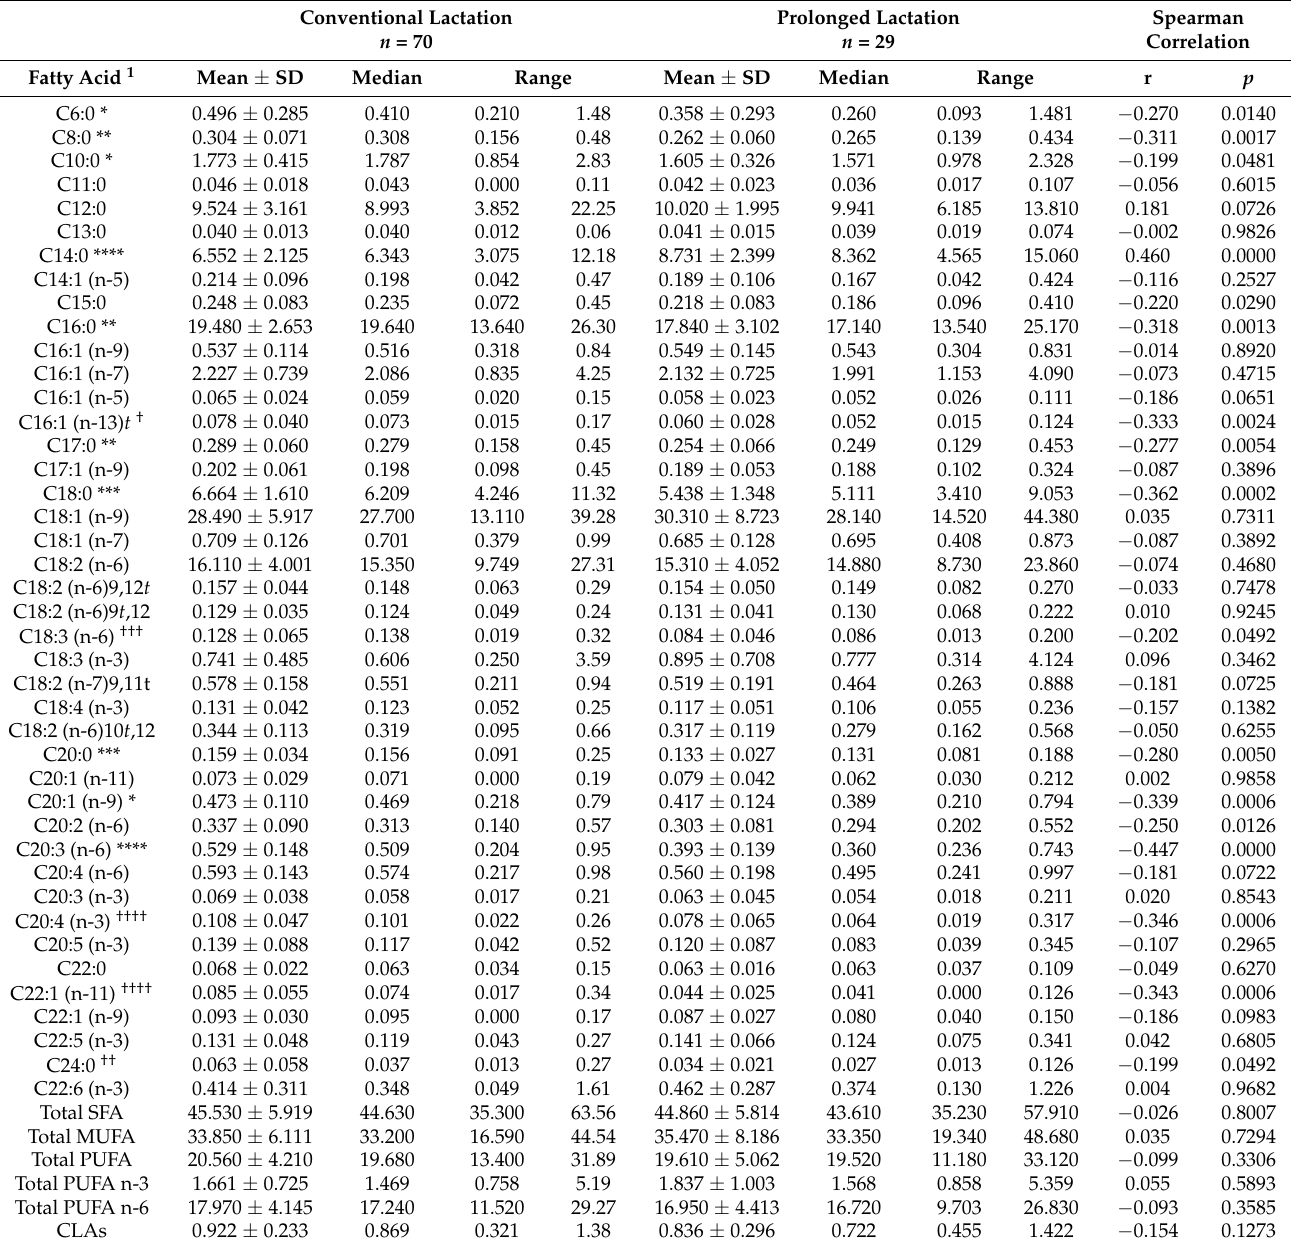
Table 6. Descriptive statistics of fatty acid levels (% wt/wt of total fatty acids) in breast milk during conventional (<6 months, n = 70) and prolonged ( ≥ 6 months, n = 29) lactation in healthy Spanish mothers; correlations between lactation time and fatty acid abundance. Conventional Lactation Prolonged Lactation Spearman n = 70 n = 29